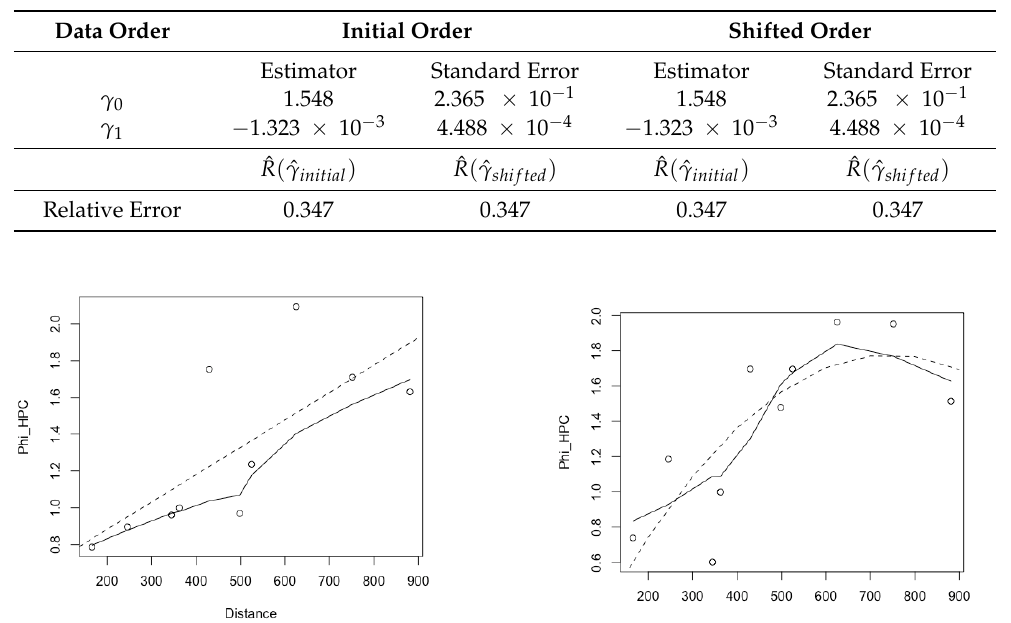
Table 3. Resulting AHPC estimates and standard error of correlation components γ , under initial and shifted order, respectively. Relative errors between sample and estimated correlation under different orders are cross compared.